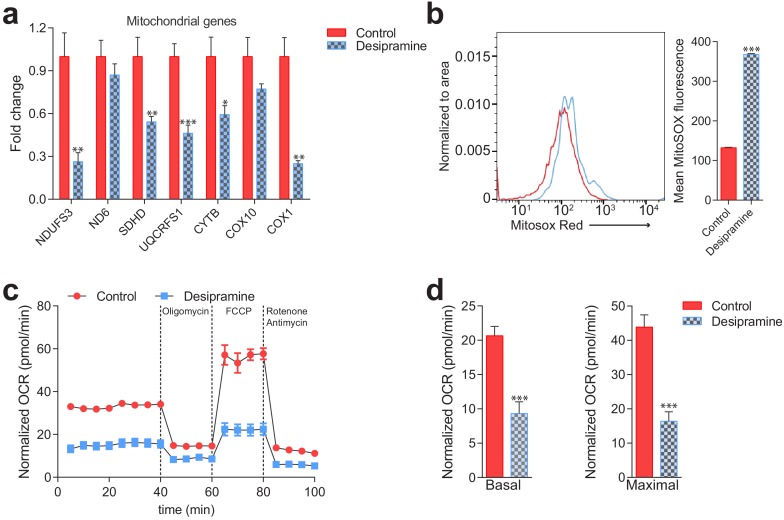
Mitochondrial deficits in control fibroblasts treated with desipramine 40 µM for 72 hr (inhibitor of acid sphingomyelinase).(a) Transcript levels of mitochondrial genes depicted as mean ± s.e.m., n = 3. T-test p-values *p<0.05 **p<0.01 ***p<0.001. Sterile distilled water used as vehicle control. (b) Increased mitochondrial superoxide levels, as assessed by MitoSox intensity, in desipramine-treated cells measured by flow cytometry. The plot shows MFI ± s.e.m., n = 5. T-test p-values ***p<0.001 (c–d) Decreased Oxygen consumption rate (OCR) in desipramine-treated fibroblasts under the indicated conditions, quantified in panel d) as average ± s.e.m., n = 2 of at least eight technical replicates each. Sterile distilled water used as vehicle control.